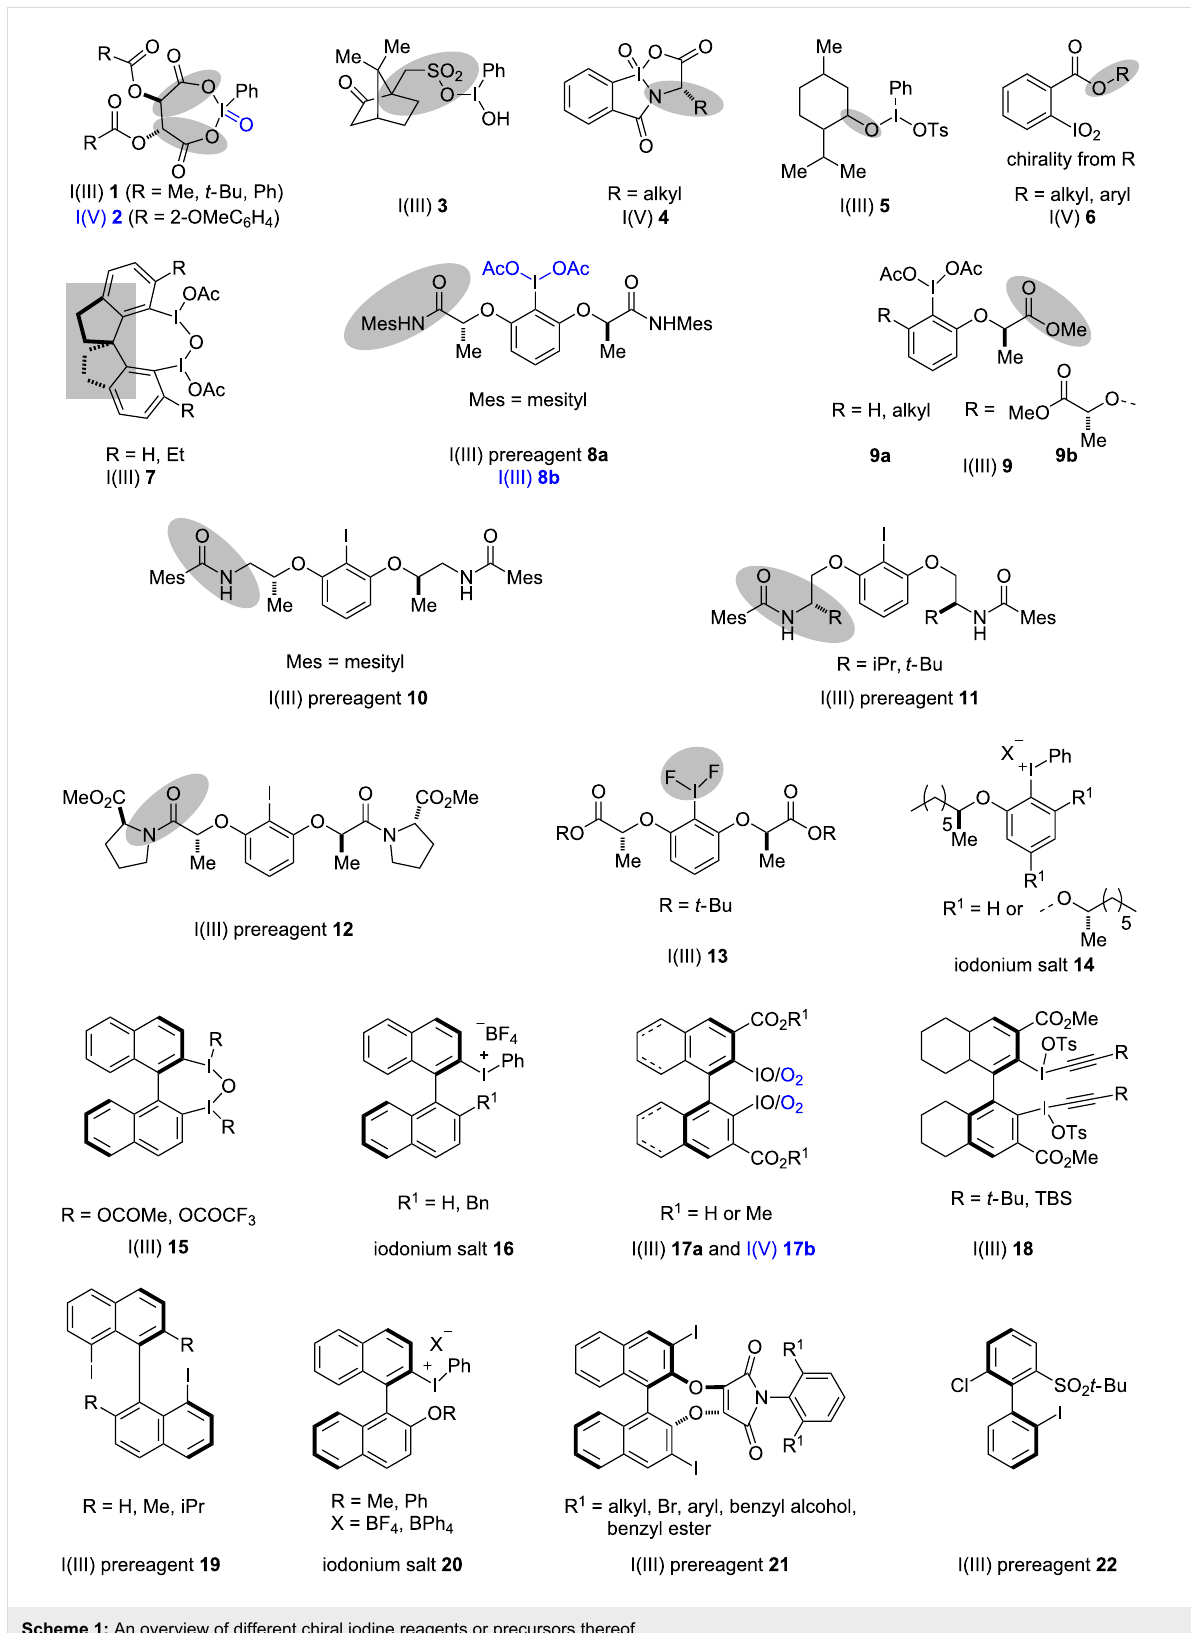
Scheme 1: An overview of different chiral iodine reagents or precursors